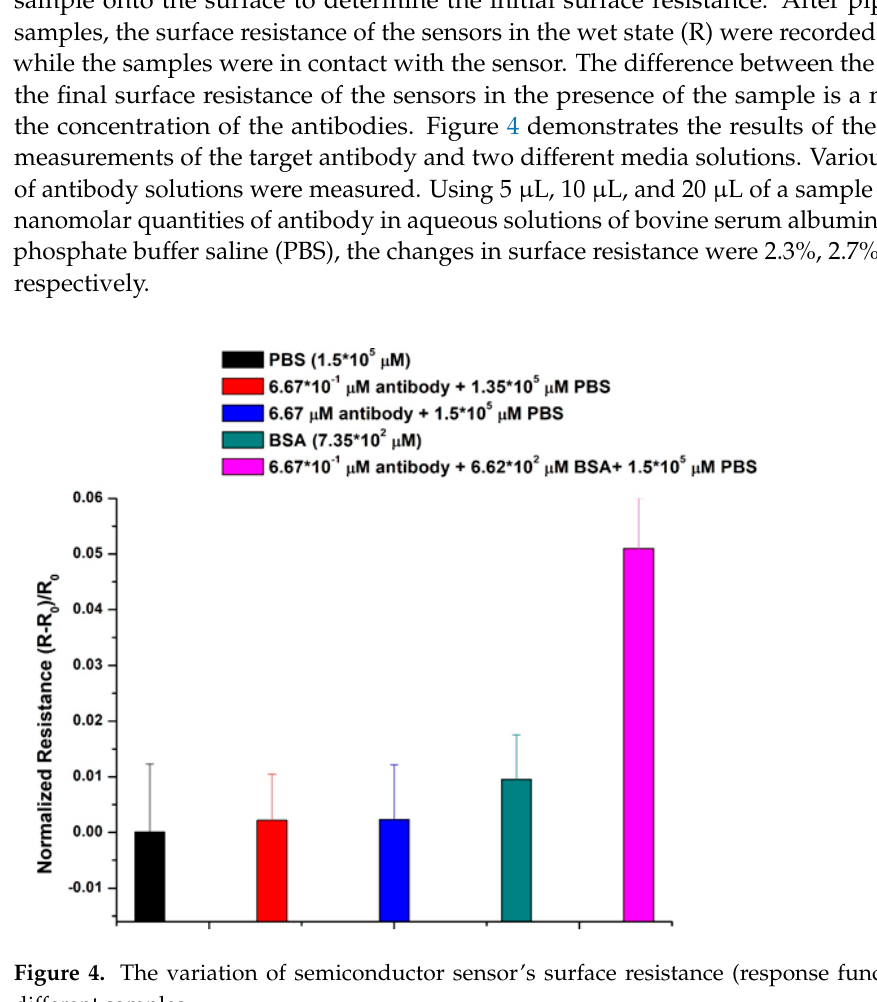
Figure 3. The schematic circuit used for resistance and current measurements of the sensor includ- ing a voltage divider circuit with a known resistor and an analog-to-digital converter (ADC) or microcontroller with a USB interface.